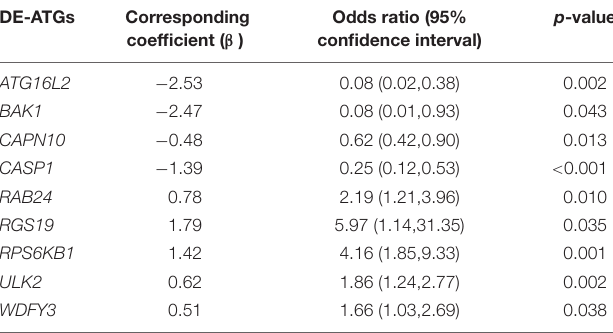
TABLE 1 | The coefficients and odds ratio (OR) value of 9 DE-ATGs estimated by Logistics regression. DE-ATGs Corresponding Odds ratio (95% coefficient ( β ) confidence